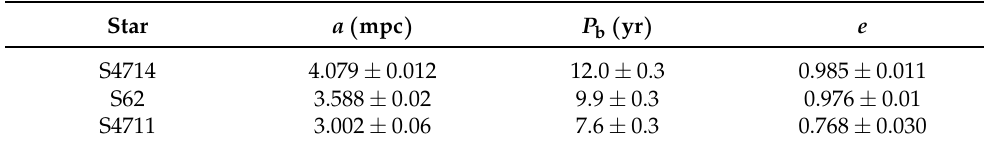
Table 1. Key orbital parameters of some fast-revolving S-stars as per Table 2 of Peißker et al. [13]. Here, the semimajor axis a is in milliparsecs (mpc), the orbital period P b is in yr, and the eccentricity e is dimensionless. Star a ( mpc ) P b ( yr